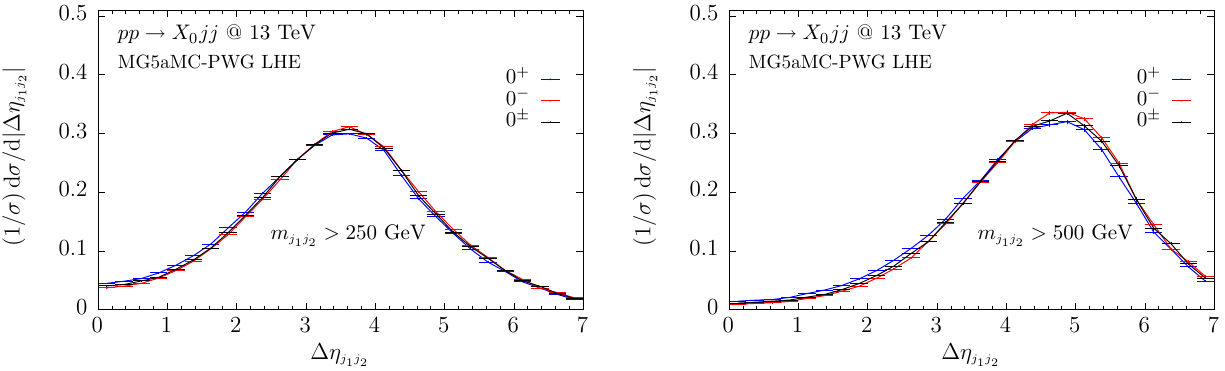
Fig. 6 Normalised differential cross section as a function of the pseudorapidity separation of the two leading jets (see Eq. (3.9)), for the three CP scenarios. On the left panel, a cut of 250 GeV is imposed on the dijet mass, while on the right panel a cut of 500 GeV is applied. The colour code is the same as in Fig.